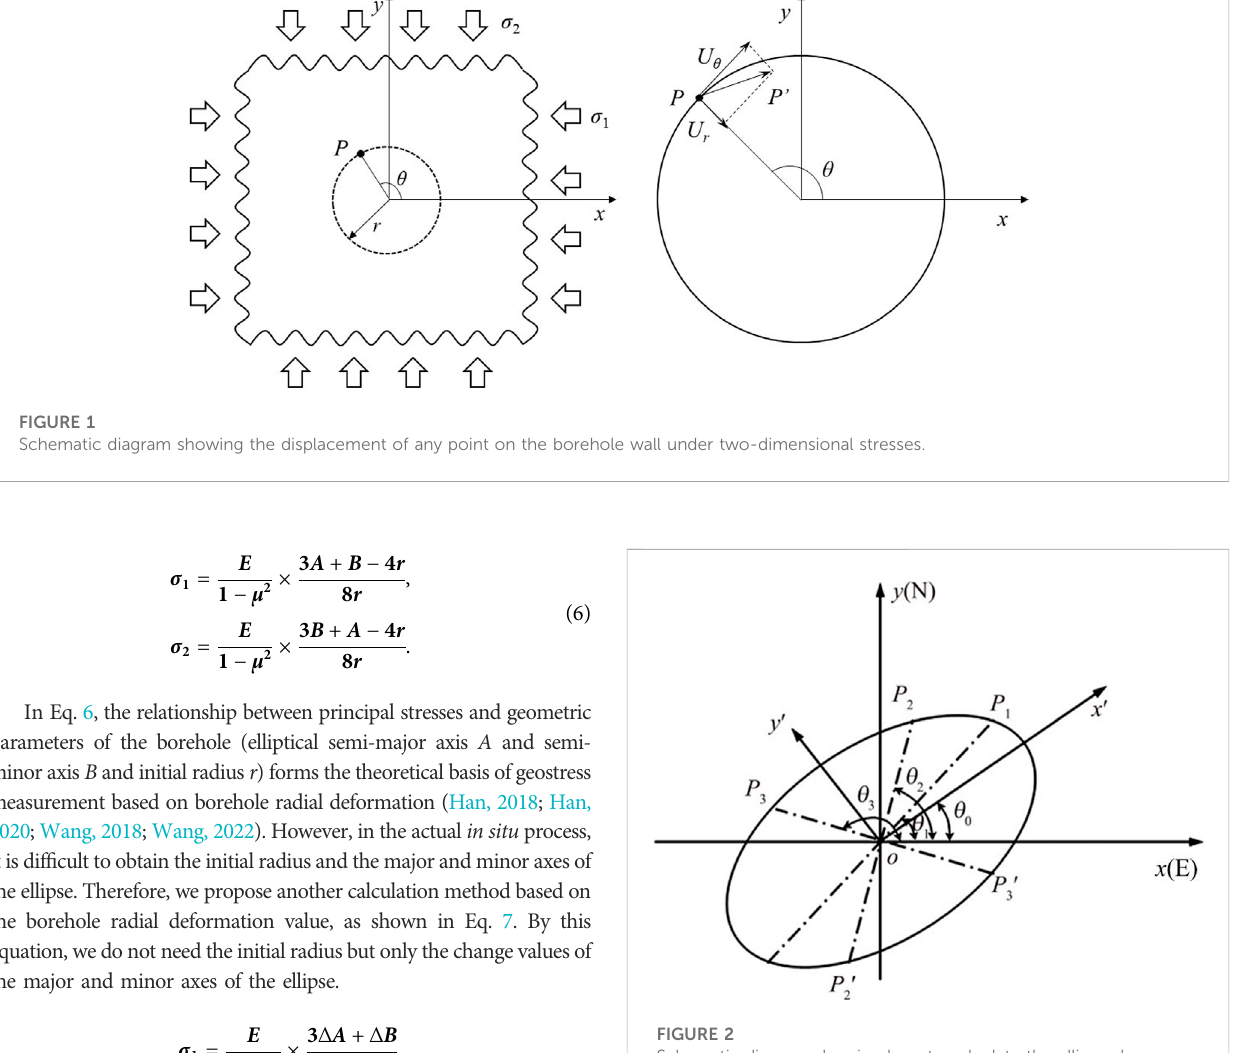
FIGURE 2 Schematic diagram showing how to calculate the ellipse shape parameters by diameters in three different